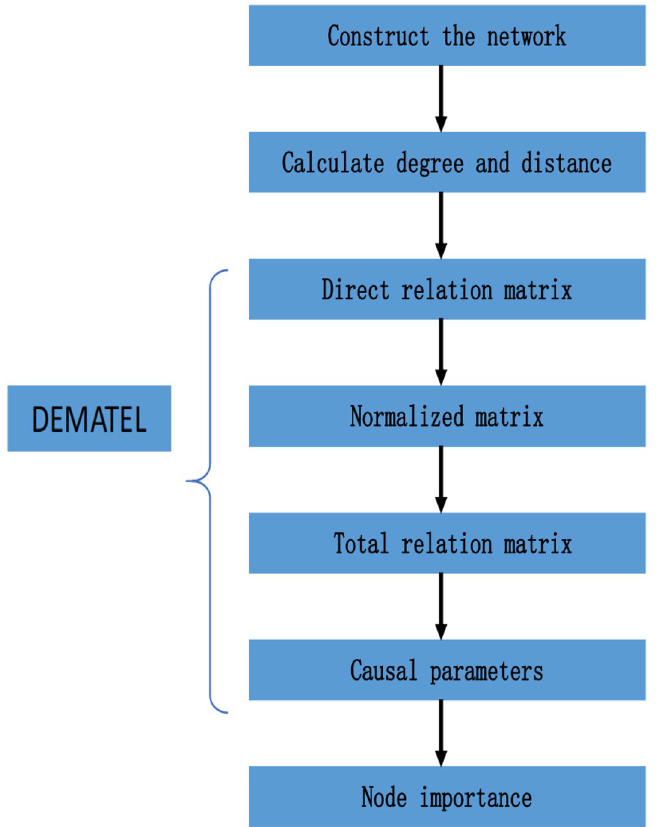
Figure 1. The flow chart of the new model.